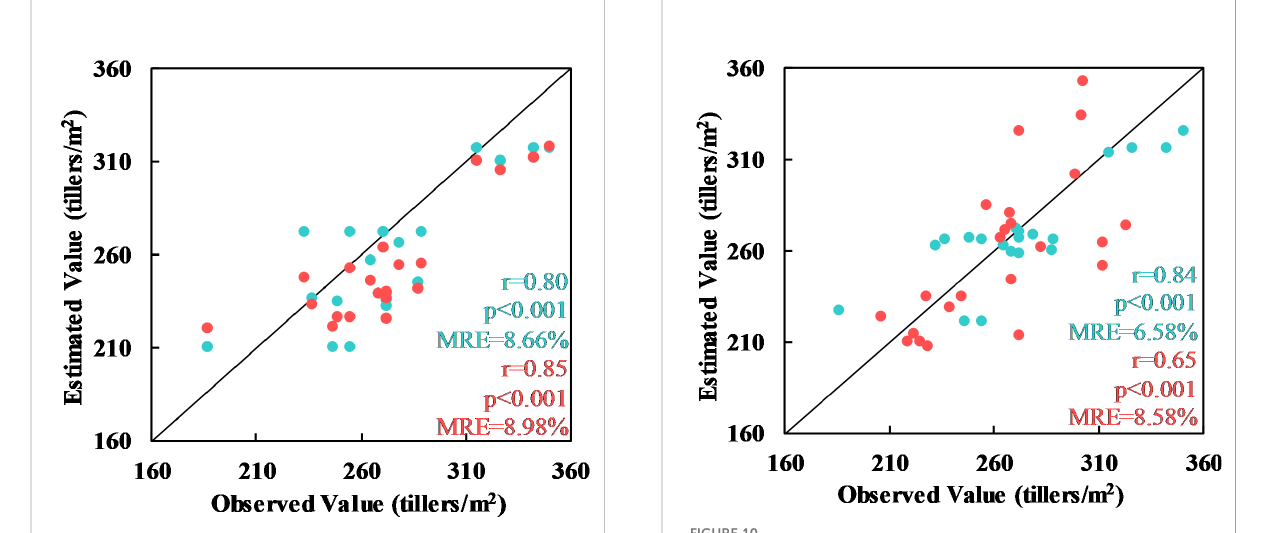
FIGURE 8 Estimated values of the tiller density based on values extracted from manually counted data (cyan) and digital photographs (red).